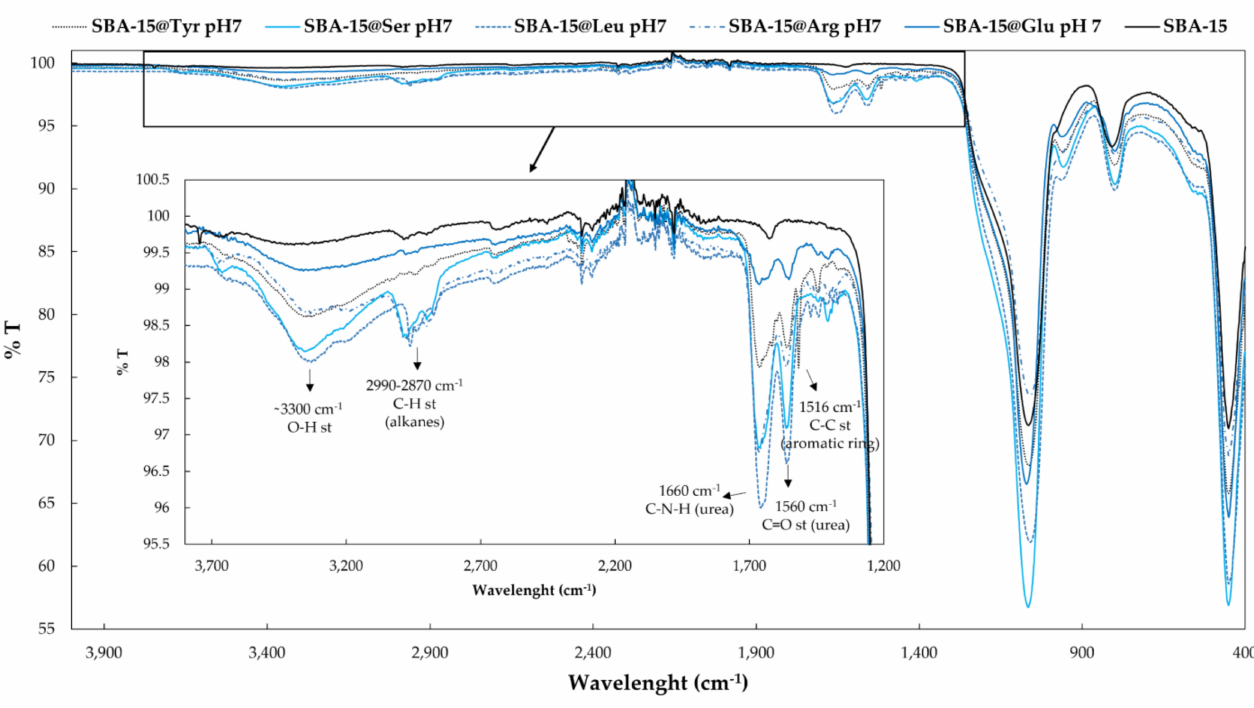
Figure 9. FT-IR spectra of the bare SBA-15 and the functionalized SBA-15@AA at pH